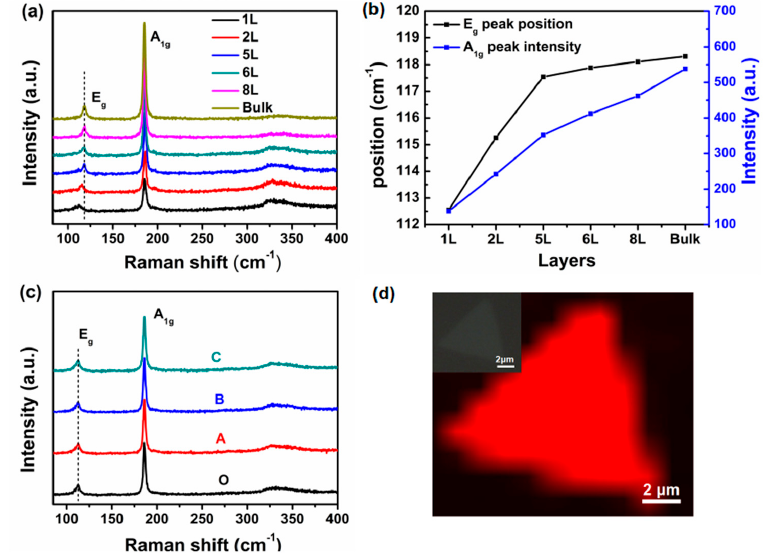
Figure 4. Raman characterization of the SnSe 2 nanoflakes. ( a ) Thickness-dependent Raman spectra of the as-synthesized SnSe 2 nanoflakes on mica substrate; ( b ) The position of the E g peak and the intensity of the A 1g peak versus number of SnSe 2 layers; ( c ) Raman spectra from four different positions of a triangular sample (corresponding Raman optical image in Figure S3); ( d ) Raman mapping of A 1g mode of a typical triangular SnSe 2 nanoflake. Inset: corresponding Raman optical